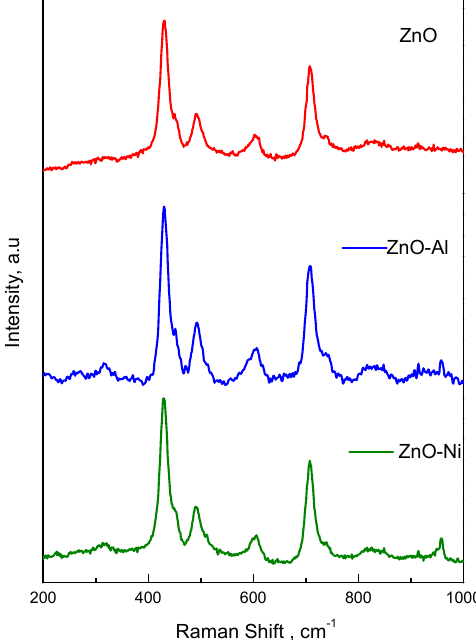
Figure 2. Raman spectra of ZnO, ZnO–Al, and ZnO–Ni samples obtained by a sol–gel method assisted by ultrasound irradiation.